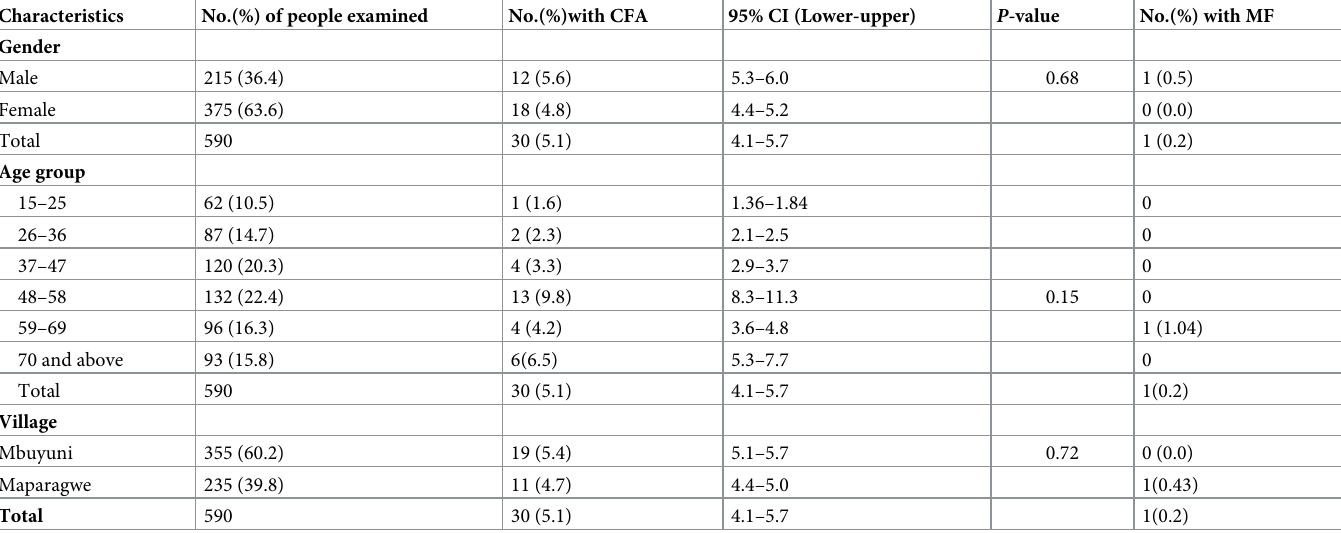
Table 2. Prevalence of CFA and microfilariae infection by gender, age group and village. Characteristics